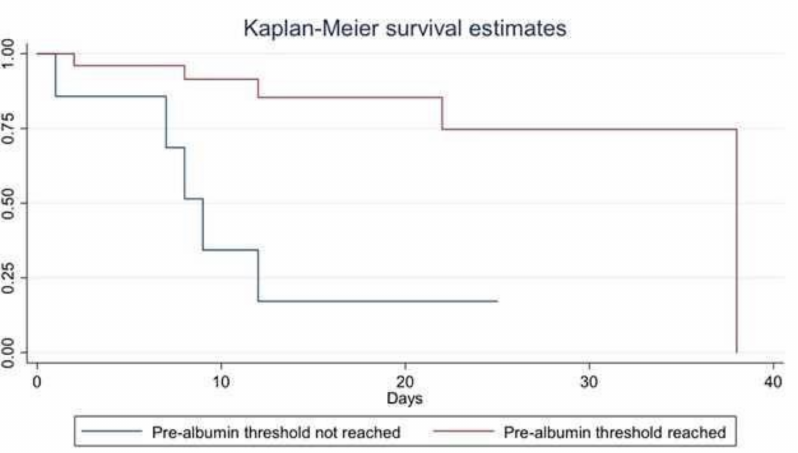
Figure 5. Comparison of survival of patients who reached and maintained the pre-albumin threshold (in green) and patients failing to reach and maintain it (in red). The patients who were able to reach and maintain the serum pre-albumin level threshold > 10 mg/dL showed a greater ICU survival (Log-rank test, p < 0.00001).